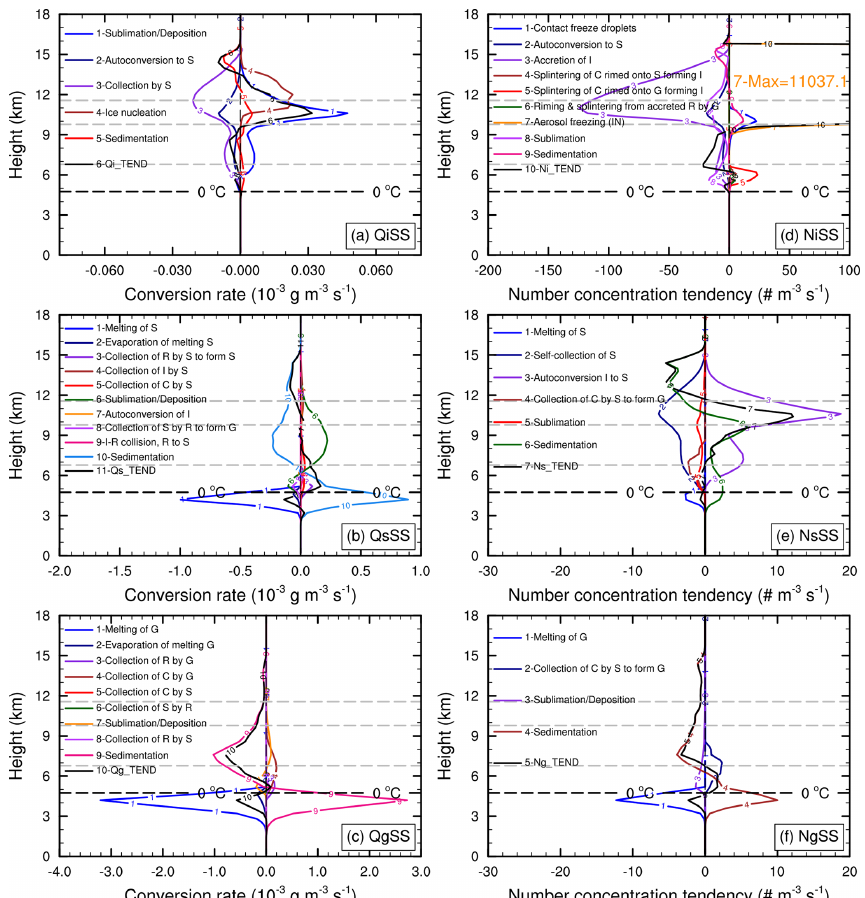
Figure 13. Vertical profiles of (a–c) averaged mass conversion rates (solid lines, 10 − 3 gm − 3 s − 1 ) and (d–f) averaged number concentration tendencies (solid lines, #m − 3 s − 1 ) of (a, d) cloud ice, (b, e) snow, and (c, f) graupel due to different microphysical processes in MORR. Only the profiles whose column-maximum conversion rates are larger than 10 − 6 gm − 3 s − 1 and column-maximum number concentration tendencies are larger than 1m − 3 s − 1 are shown in (a–c) and (d–f) , respectively. The total microphysics tendencies of cloud ice ( a : Qi_TEND, d : Ni_TEND), snow ( b : Qs_TEND, e : Ns_TEND), and graupel ( c : Qg_TEND, f : Ng_TEND) are shown by black solid curves. The horizontal thin black and gray dashed lines indicate the heights of 0, − 10, − 30, and − 45 ◦ C from bottom to top, respectively. The numbers of samples used to calculate the averages are shown in Table 2. C: cloud ice; R: rain water; I: cloud ice; S: snow; and G: